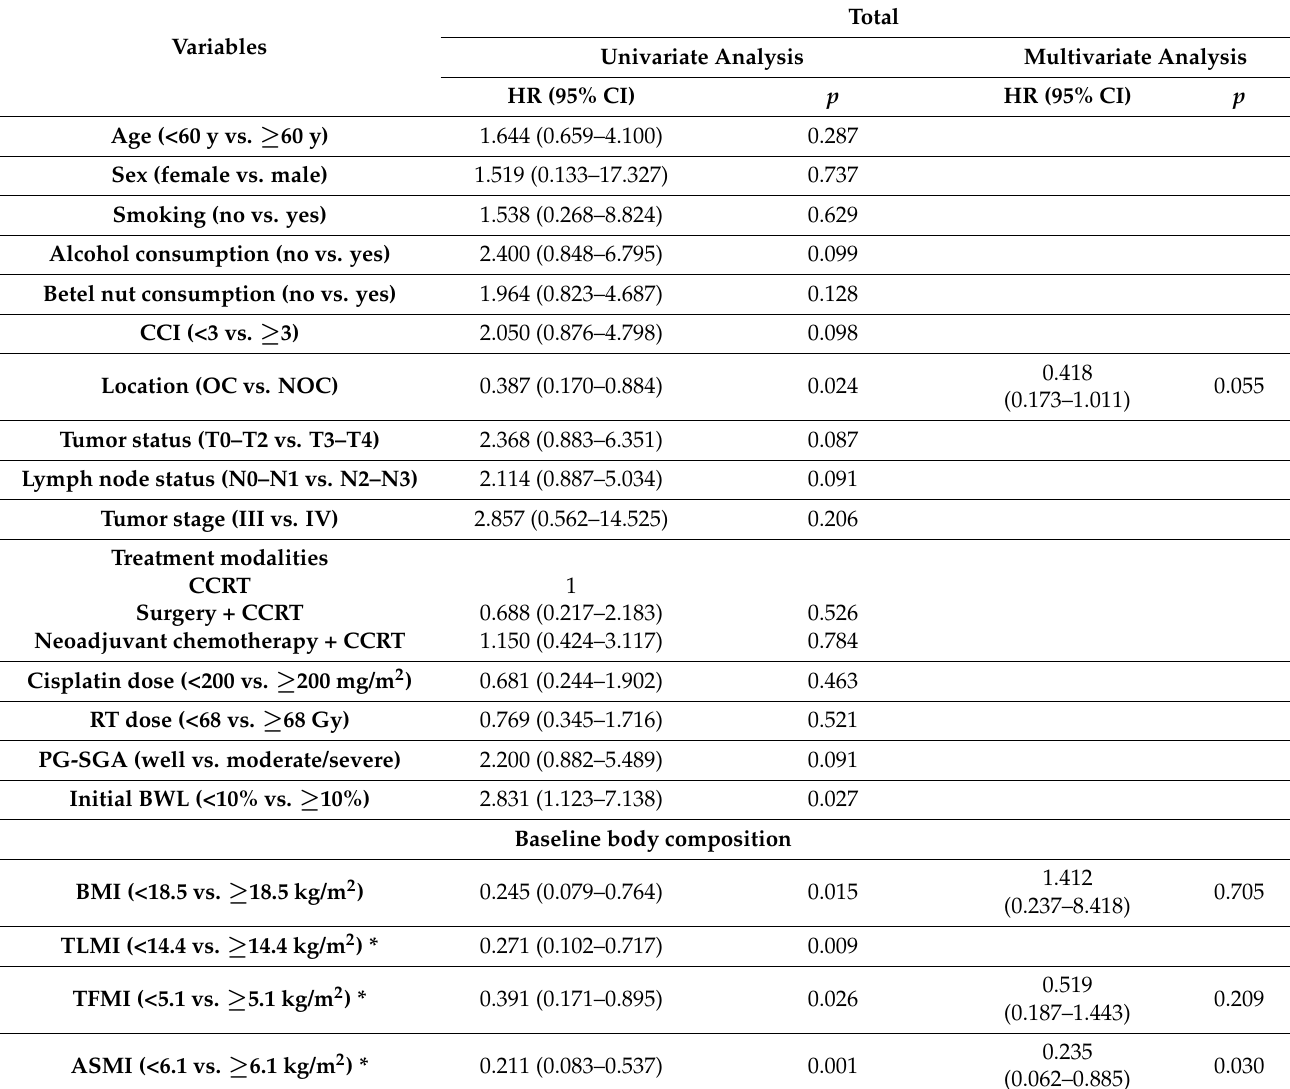
Table 2. Univariate and multivariate analyses of prognostic factors associated with the 2-year recurrence-free survival rate (RFSR) of patients with